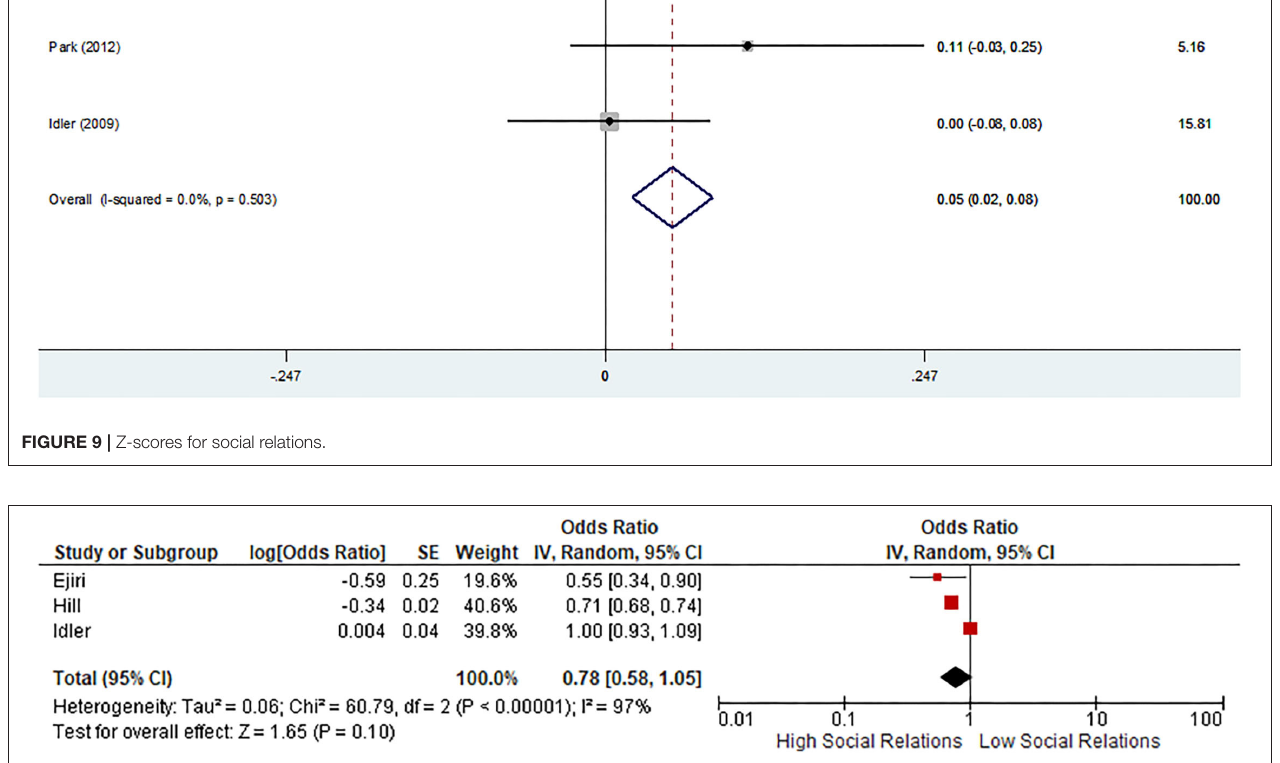
FIGURE 10 | Odds Ratio (OR) for social